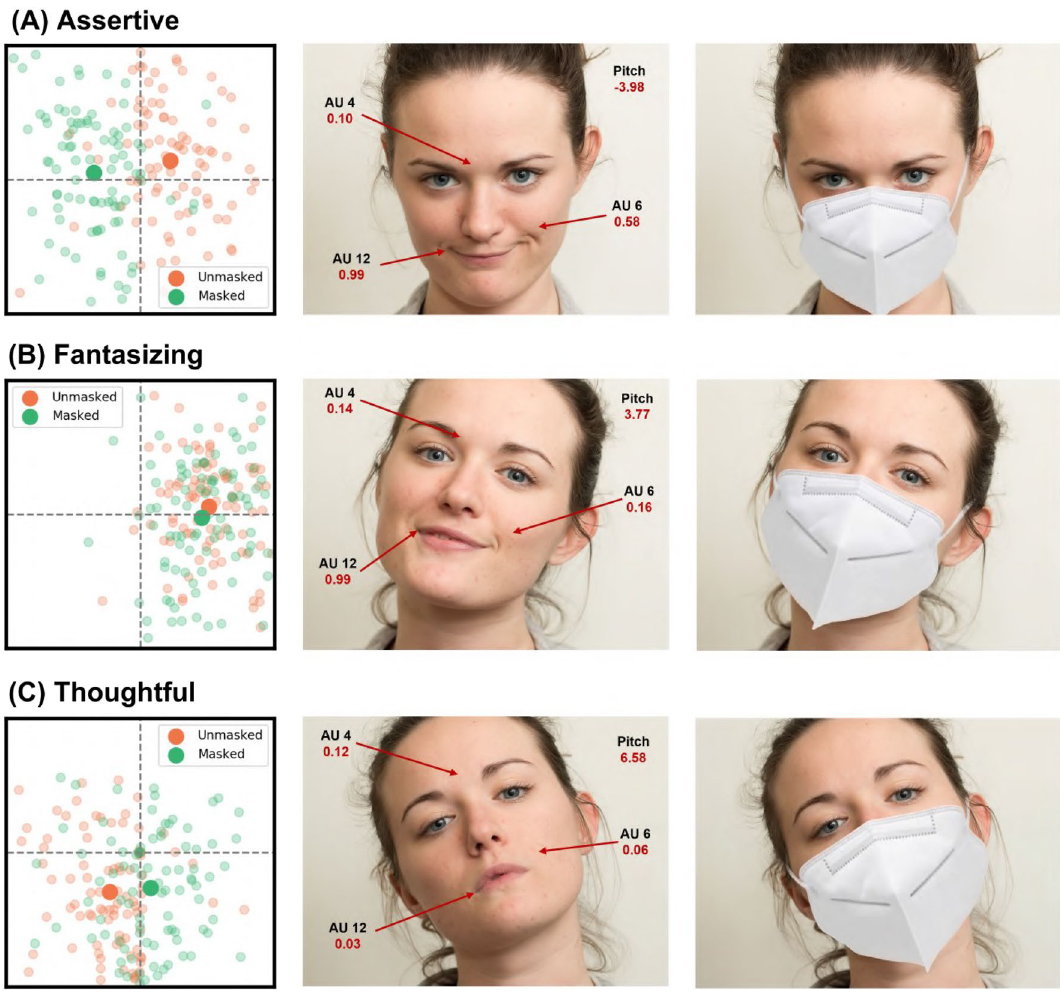
Figure 4. Comparisons of unmasked vs KN95 valence scores (x-axis) for three mental states that showed different degrees of valence changes. Lighter datapoints are individual ratings, and darker datapoints are the mean ratings in the 2D grid. Nodding forward (i.e. negative pitch) makes positive expressions appear more negative in the KN95 condition ( A ). On the contrary, nodding backward (i.e. positive pitch) helps preserve the positive valence ( B ), and renders negative mental states more positive. ( C ). Other predictors of valence are frowning (AU 4), raising the cheeks (AU 6) and smiling (AU 12). Face images were obtained with permission from the public McGill Face Database 32